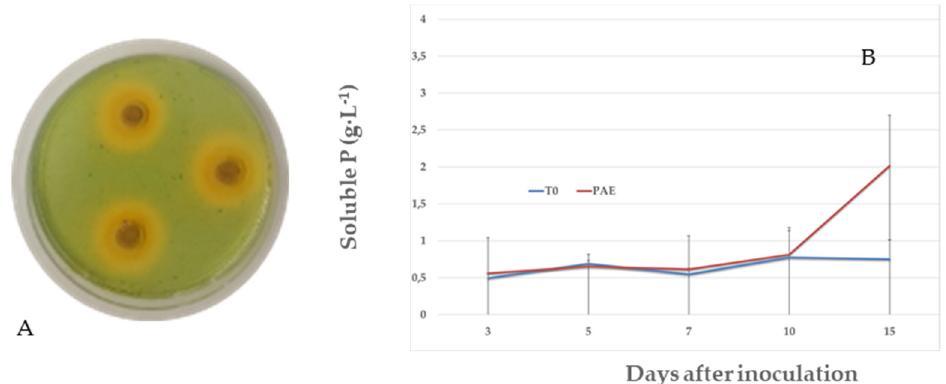
Figure 4. Formation of orange-colored halos owing to production of siderophores by P. variotii ( A ). E ff ects of P. variotii on phosphate solubilization ( B ) in NBRIP broth containing tribasic calcium phosphate (10 g). Mean standard deviation is expressed in error bar. The results are shown as the average of the three replicates, in g L − 1 .